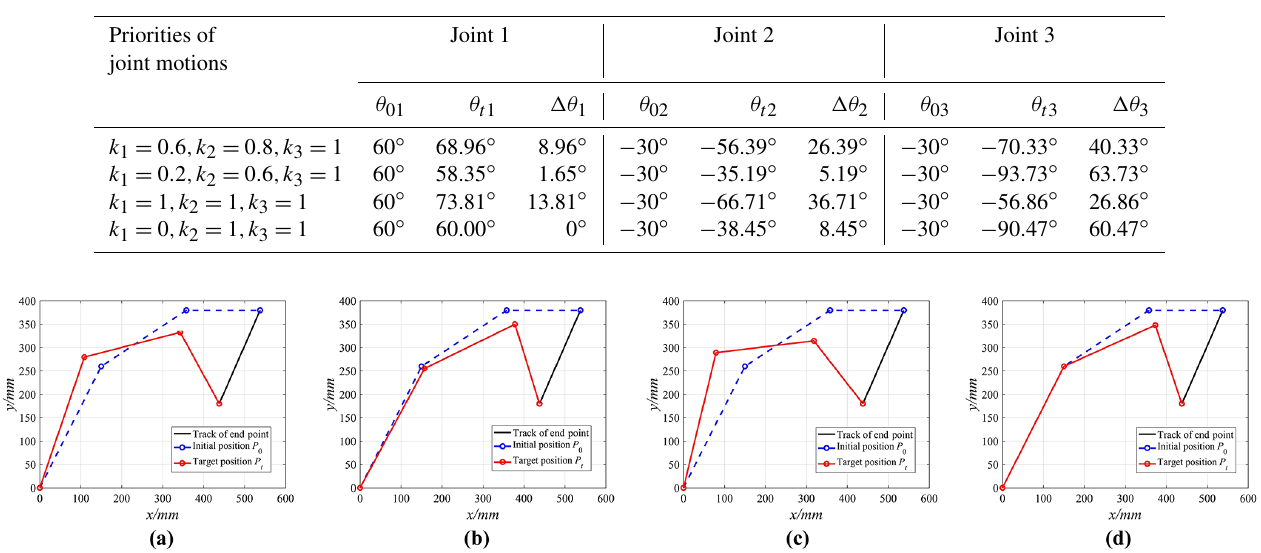
Table 1. Comparisons of joint motions with different motion priorities.